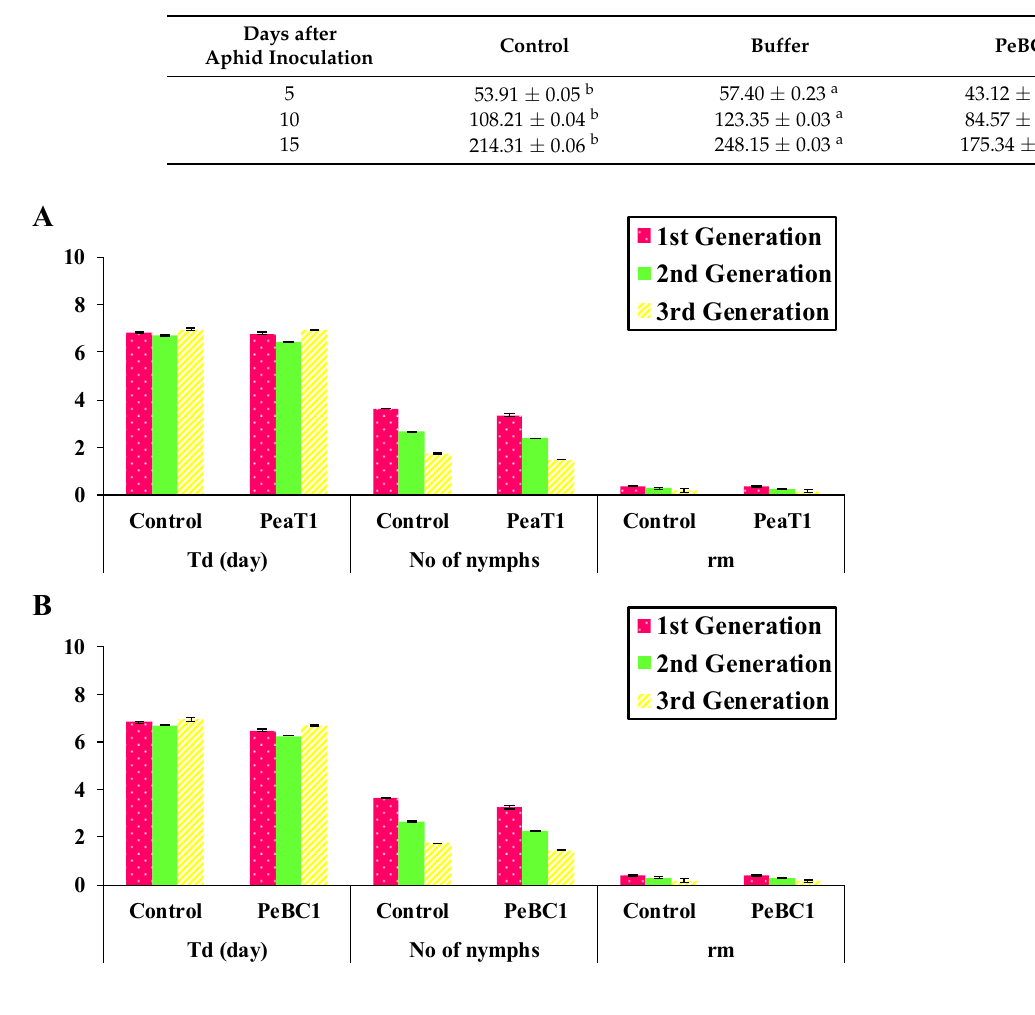
Figure 2. In PeaT1- and PeBC1-treated ( A , B ) and control seedlings of chili, developmental time, reproductive capacity, and growth of the intrinsic rate of M. persicae are reported as mean ± SD. Td stands for development period, nymphs per day stands for average reproduction ability, and r m stands for intrinsic rate rise. To compare data, SPSS 18.0 was utilized with one-way analysis of variance (ANOVA) and the least significant difference (LSD) ( p = 0.05).